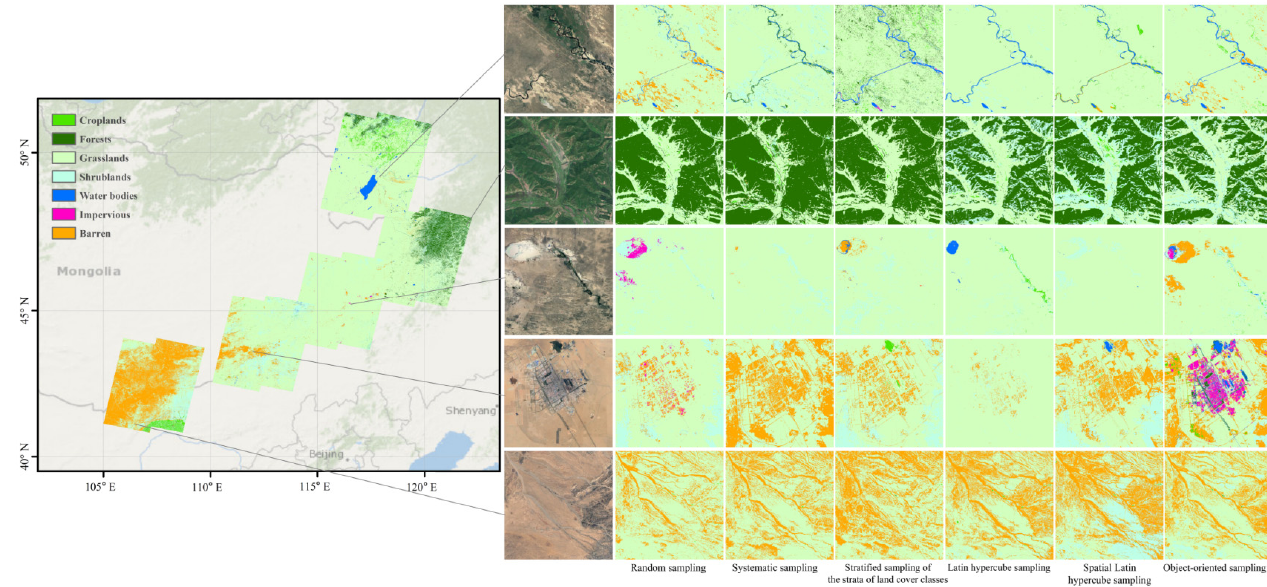
Figure 5. Classification map.